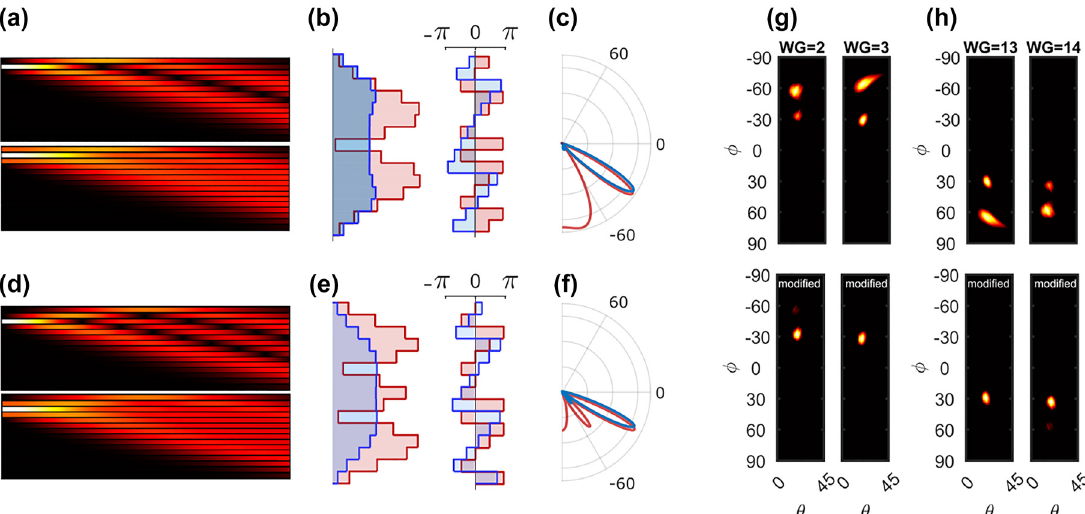
Figure 4: A comparison of the single-versus multiple-channel excitation when exciting ports 14 (a–c) and 13 (d–f) of an array of 15 elements. (a & d) The evolution of the electric field amplitudes along the array. (b & e) The output amplitude and phase patterns. (b & e) The in-plane far-field radiation patterns. In (c & f) red and blue correspond to single- and multiple-channel excitation, respectively. (g & h) The radiated far-field beam profile when the array is excited from ports 2, 3 (g) and 13, 14 (h) with single- (top) versus triple-port excitation scenarios (bottom). In the bottom panels, for excitation with a given port, the neighboring channels are excited with amplitude ratios of 0.5 with respect to the target channel. In each panel of (g & h) the beam intensity is normalized to its maximum value.